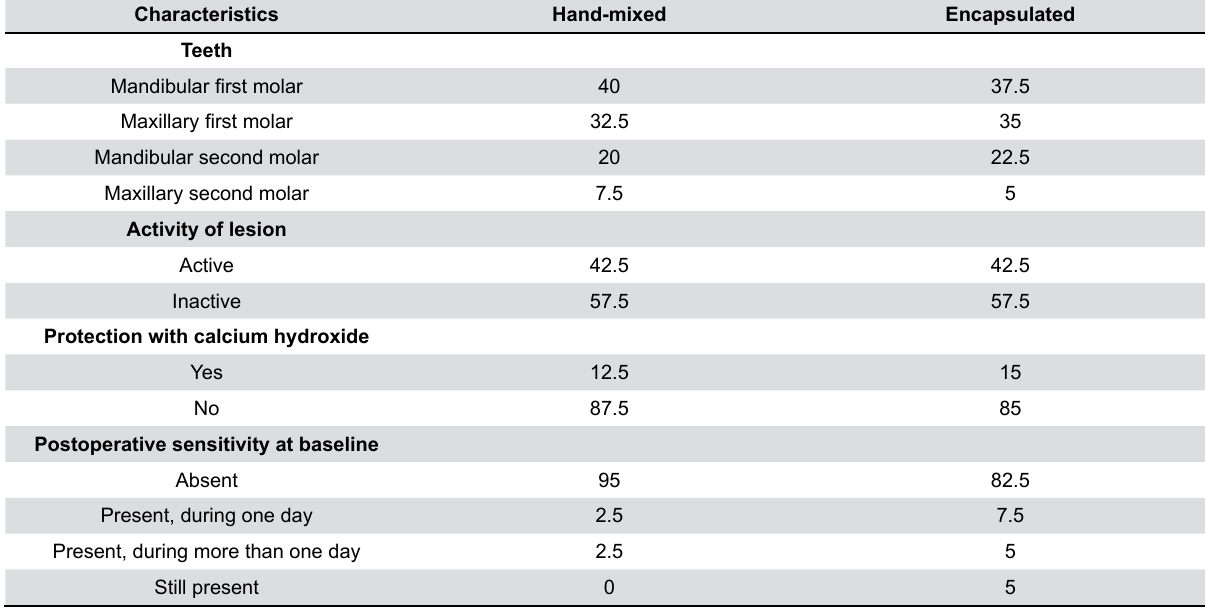
Table 2- Distribution of teeth, lesions, cavities, and restorations characteristics in percentage